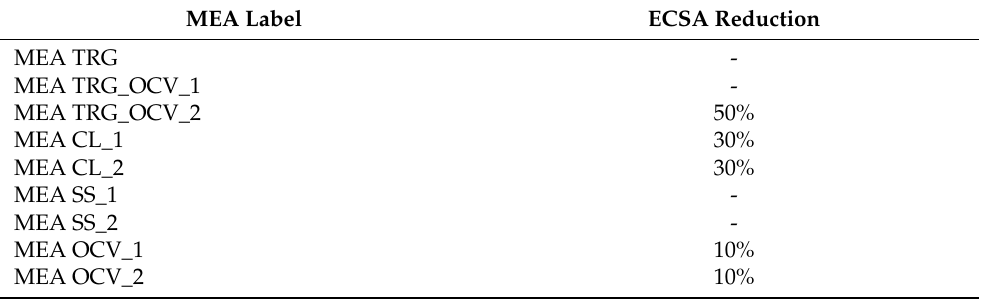
Table 2. ECSA reduction estimated with cyclic voltammetry at the beginning and at the end of the aging test.